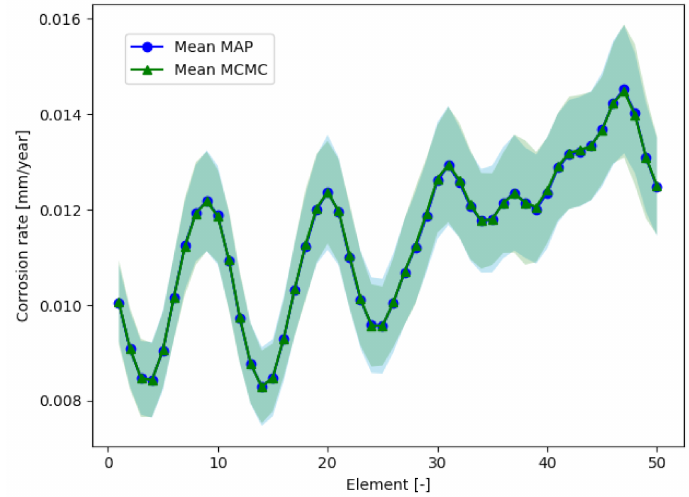
Figure 4. Posterior distributions of the corrosion rate based on stain mode shapes at all elements. The dashed areas correspond to the 68% confidence